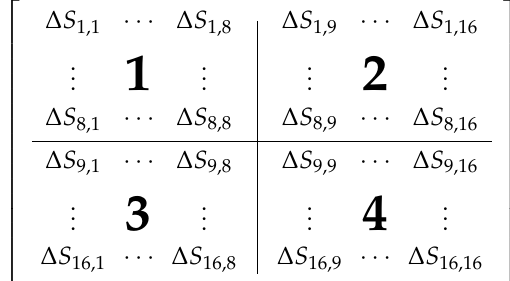
Figure 2. Partitioning of the MSR